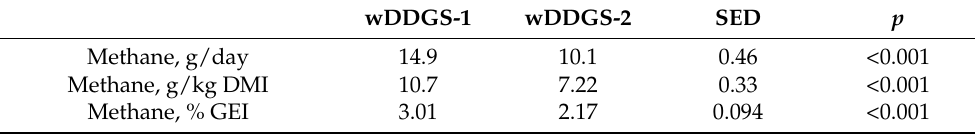
Table A2. Digestibility coefficients and metabolisable energy (ME) content of wDDGS-1 and wDDGS-2. wDDGS-1 wDDGS-2 SED p Digestibility Dry matter (DM) 0.649 0.703 0.0208 0.012 Nitrogen 0.715 0.733 0.0121 0.150 Energy 0.676 0.715 0.0190 0.004 ME (MJ/kg DM) 12.1 13.4 0.42 0.002